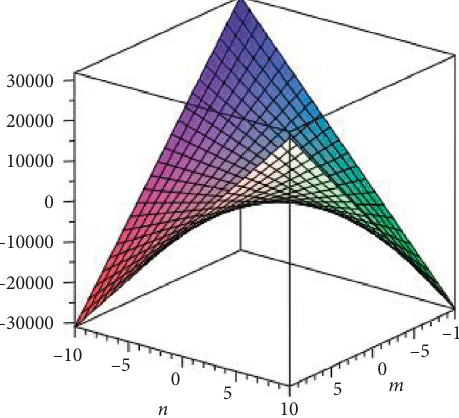
Figure 8: The 3D plot of the augmented Zagreb index for BR ( m, n ) the first Zagreb index in blue color, second Zagreb index in green color, and modified Zagreb index in red color.